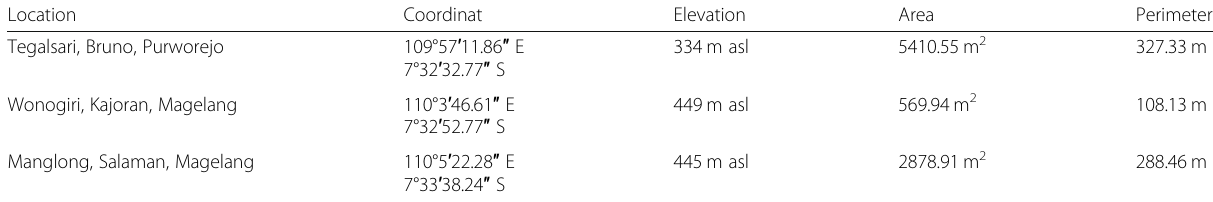
Table 1 Descriptions of three landslide study sites